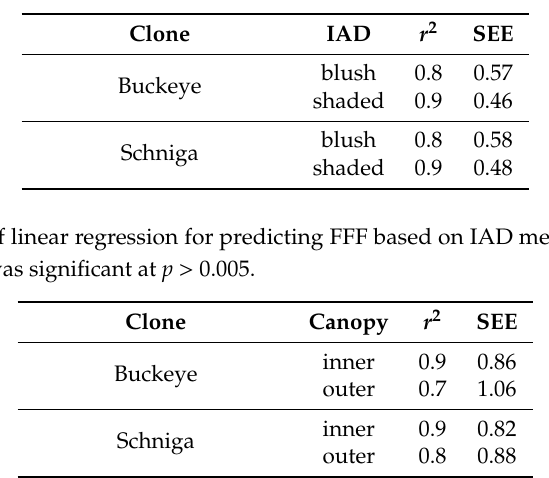
Table A6. Summary of linear regression for predicting SPI based on IAD measurements for season 2017. The regression was significant at p > 0.005.